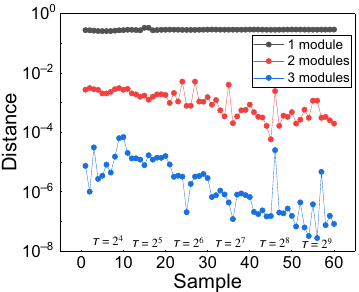
FIG. 7. The distance between the implemented nonunitary operators and the ideal ones. The calculated distance d for all sampled p and τ , with different numbers of modules in the imple- . We plot the distance for all sampled p with mentation of U ( 4 ) p τ(cid:3) = 2 n in the x -axis range ( 10 n − 40, 10 n − 30 ) .